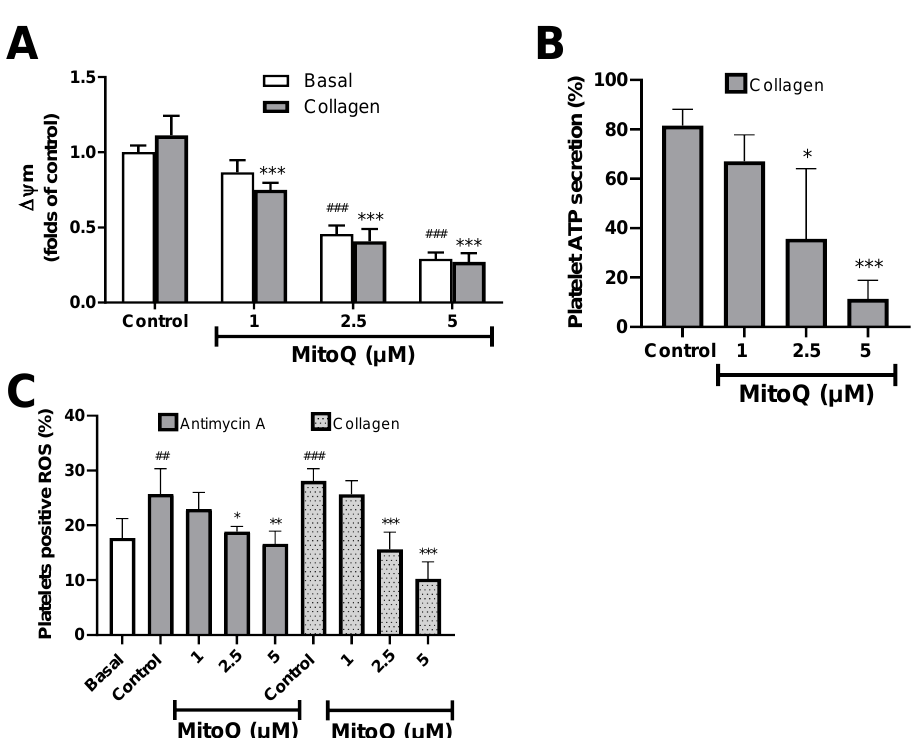
Figure 4. EffectofMitoQonmitochondrialbioenergeticsincollagen-stimulatedplatelets. ( A )Mitochondrial Figure 4. Effect of MitoQ on mitochondrial bioenergetics in collagen-stimulated platelets. ( A ) membrane potential ( ∆Ψ m) using TMRM was measured by flow cytometry. ( B ) Platelet ATP secretion Mitochondrial membrane potential (∆Ψm) using TMRM was measured by flow cytometry. ( B ) was measured using chronolume reagent and expressed as a percentage. ( C ) Intraplatelet reactive Platelet ATP secretion was measured using chronolume reagent and expressed as a percentage. ( C ) oxygen species (ROS) generation was measured using DHE probe in a flow cytometer. ( A ) and ( C ) Intraplatelet reactive oxygen species (ROS) generation was measured using DHE probe in a flow Platelets were identified as the CD61 + population and expressing the CD61 from these populations cytometer. ( A ) and ( C ) Platelets were identified as the CD61 + population and expressing the CD61 were analyzed in terms of change in mean fluorescence intensity from control ( ∆Ψ m) and percentage of DHE-positive platelets (ROS production). Representative dot plots of ∆Ψ m and ROS assays were included as Supplementary Figures S9 and S10. The statistical analysis was performed using the ANOVA (Tukey test). ## p < 0.01 and ### p < 0.001 vs. basal, and * p < 0.05, ** p < 0.01 and *** p <